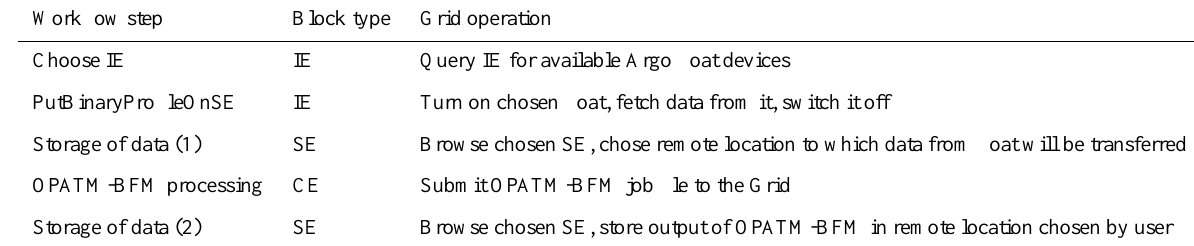
Table 1. Details of the OCOM-MOON